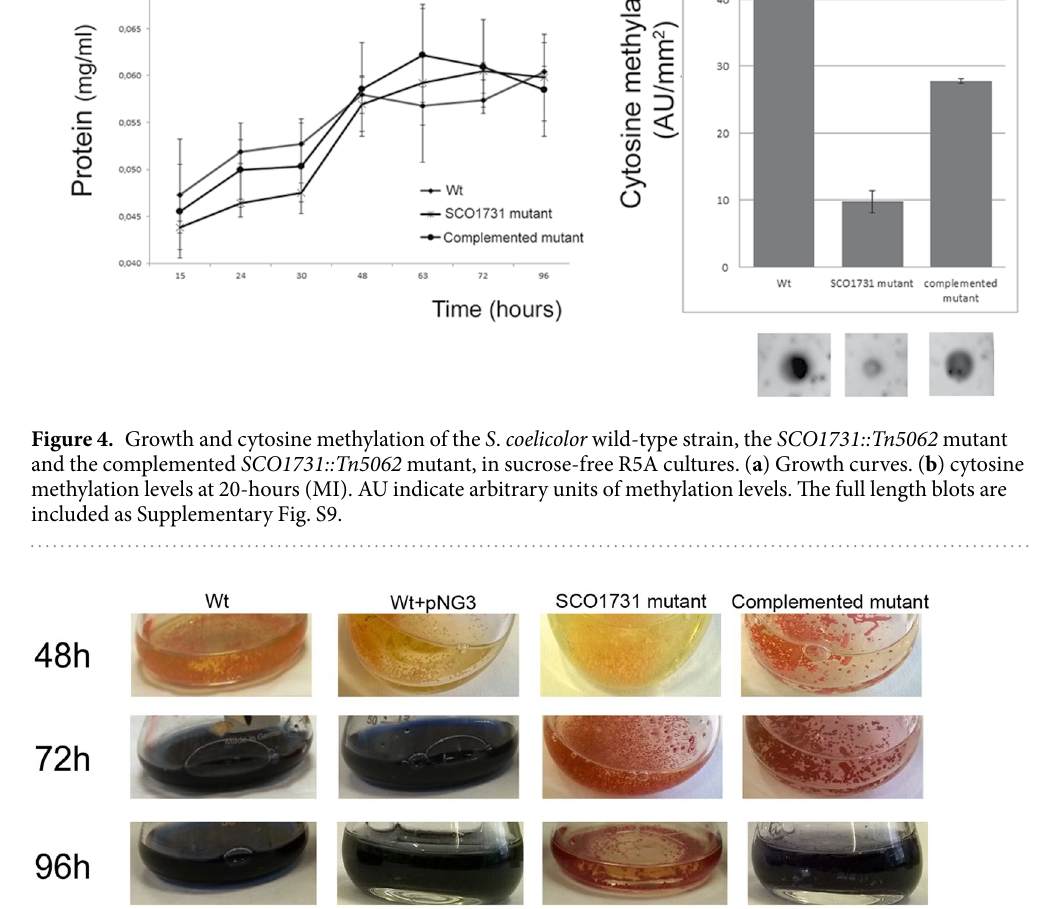
Figure 5. Actinorhodin production in sucrose-free R5A cultures of the S . coelicolor wild-type strain, the SCO1731::Tn5062 mutant and the SCO1731::Tn5062 complemented strain. Macroscopic view of laboratory flasks is shown at different developmental time points (48 h, 72 h and 96 h). Blue color corresponds to actinorhodin; red colour corresponds to